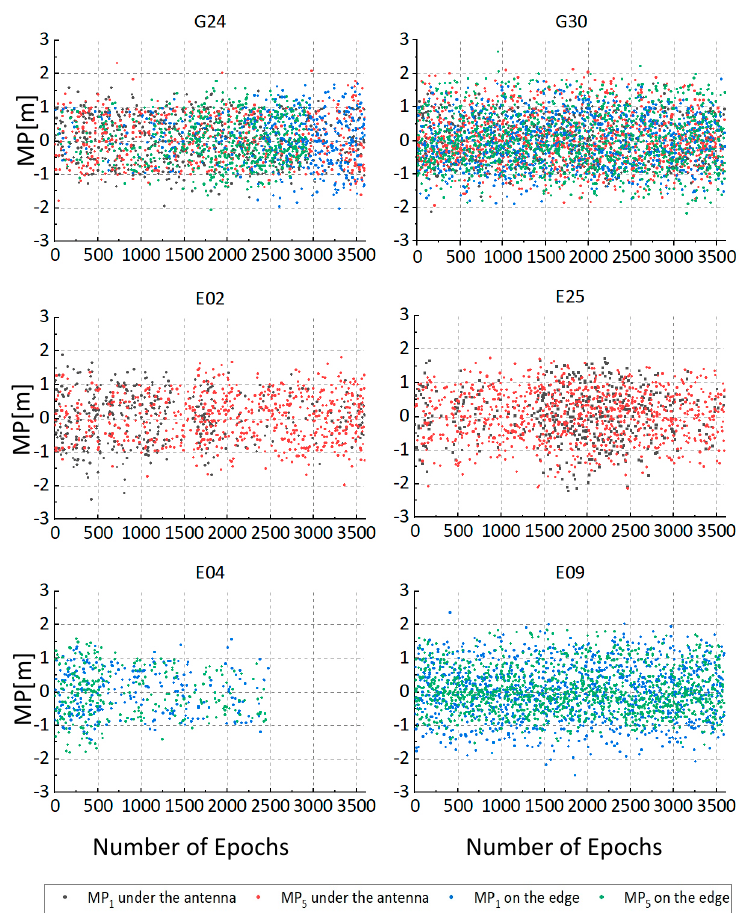
Figure 3. Horizontal position errors of four data sets in PPP kinematic mode. Table 2. STD of 𝑀𝑃 (cid:2869) and 𝑀𝑃 (cid:2873) in two cases.